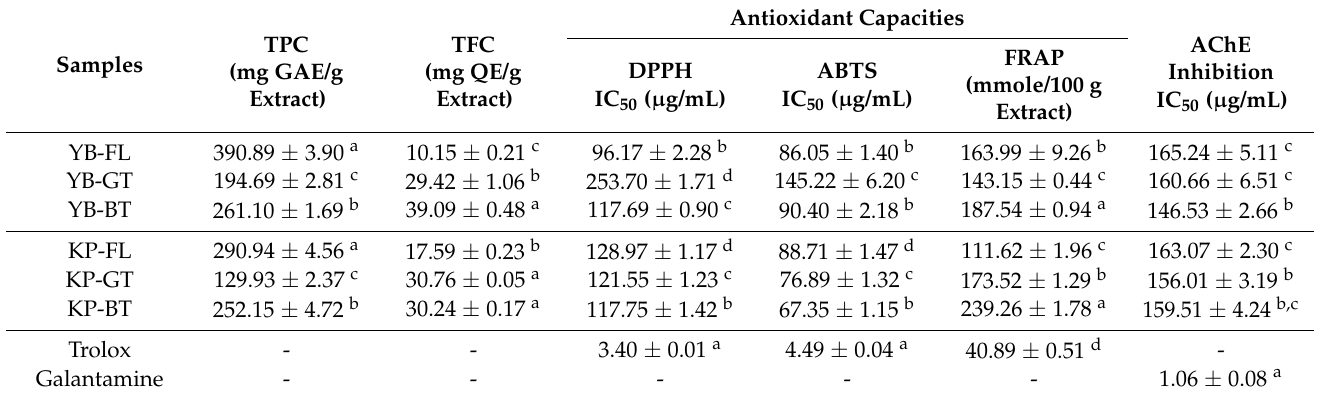
Table 1. Antioxidant activities and AChE inhibitory effect of mulberry leaf